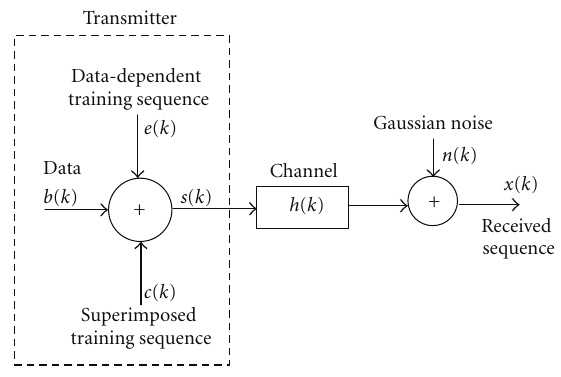
Figure 1: Digital communication system model